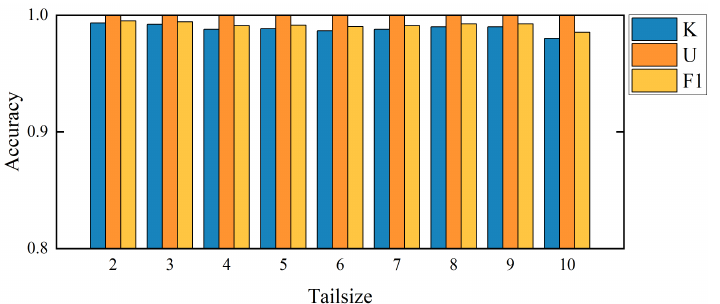
Figure 13. The relationship between the tailsize value and precision of the SEU dataset.